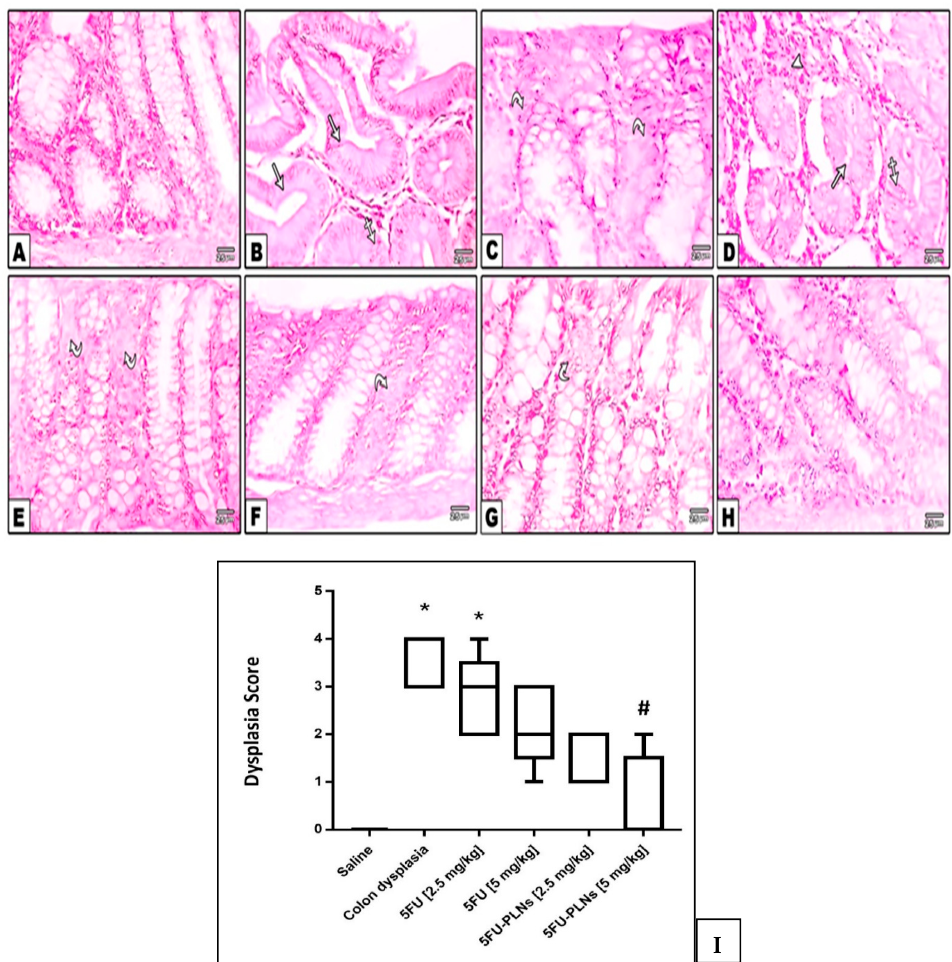
Figure 7. Photomicrographs of hematoxylin and eosin stained colonic specimens demonstrating intact crypts lined by normal appearing epithelial cells and goblet cells in the vehicle control group ( A ). In the colon hyperplasia control group, the foci of variable grades of hyperplasia and dysplasia were detected where crypts were enlarged, elongated, crowded, and irregular (straight arrows) lined by atypical closely packed epithelial cells having stratified hyperchromatic nuclei (crossed arrows), markedly reduced goblet cells accompanied with multifocal areas of cell proliferation (curved arrows), and dense inflammatory cell infiltration in lamina propria (arrow head) ( B – D ). In Free 5FU [2.5 & 5 mg/kg] treated groups, the crypts were less crowded, showing focal hyperplastic lining with small areas of cell proliferation (curved arrows) ( E , F ). In 5FU-PLNs [2.5 mg/kg] treated group, crypts were relatively straight, less crowded, with very small area of cell proliferation (curved arrow) ( G ). In the 5FU-PLNs [5 mg/kg] treated group, crypts were straight, lined by normal appearing epithelial cells and goblet cells ( H ) X400. ( I ) A box plot chart for the median histologic score and quartiles. Data were analyzed using the Kruskal–Wallis test and Dunn’s test at p < 0.05. *: Versus saline group, # : Versus colon dysplasia group.